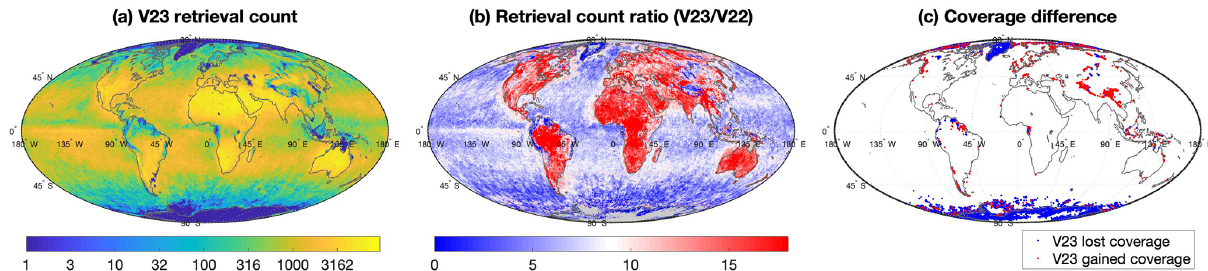
Figure 6. (a) Number of MISR V23 retrievals from 2012, gridded at 0.5 ◦ resolution, the color scale is presented in decimal logarithm. (b) Ratio between the number of V23 retrievals and V22 retrievals; the average ratio, represented by white color in the color scale, is ∼ 9 . 0. (c) Locations of grid points where V23 loses (blue) or gains (red) coverage in comparison to